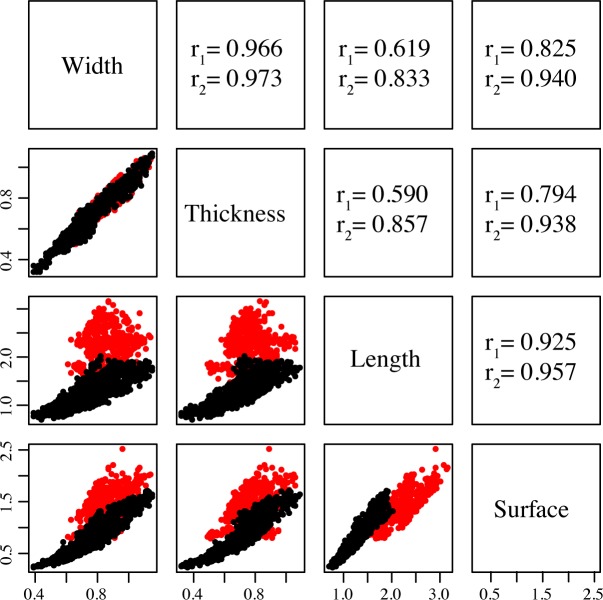
Correlation of size parameters.Red: Phoenix dactylifera, black: all Phoenix except P. dactylifera, in mm. Each pair of correlations is plotted on the lower left side while the coefficients of correlation r are given on the upper right-hand side: r1 corresponds to the correlation coefficients when all Phoenix species are included while r2 were calculated after discarding the date palm P. dactylifera.